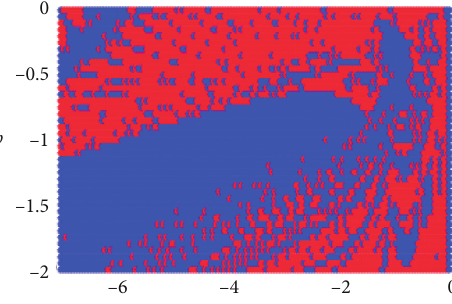
Figure 4: Basin attractors of system (1) for c � 1 at various values of a and b